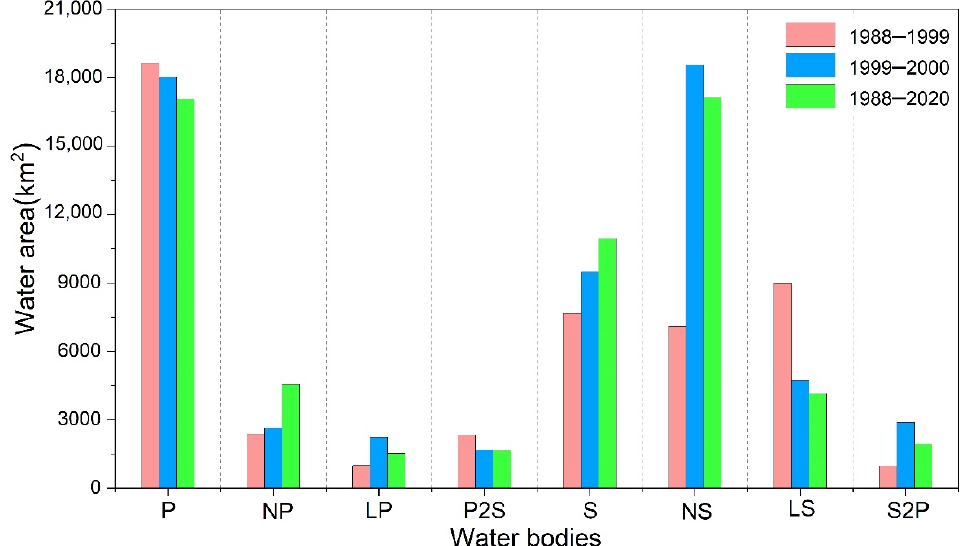
Figure 5. Transformation of surface water bodies in the study area for 1988–1999, 2000–2020, and 1988–2020. Among them, the conversion types are unchanged permanent (P), new permanent (NP), lost permanent (LP), permanent to seasonal (P2S), unchanged seasonal (S), new seasonal (NS), lost seasonal (LS), and seasonal to permanent